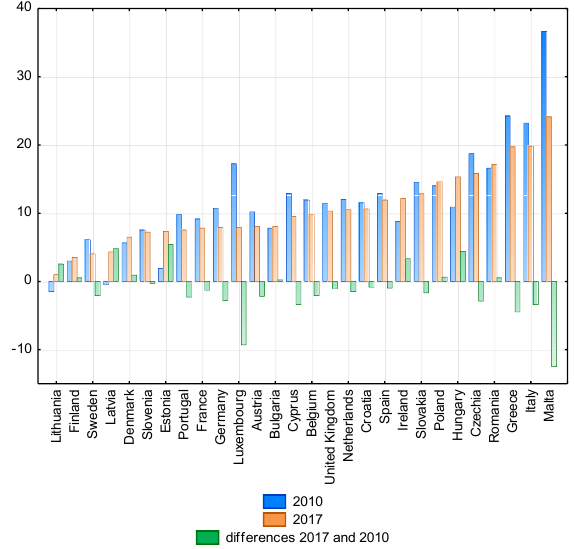
Figure 6. Employment rate gender gap in the European Union countries for the years 2010 and 2017 Table 2. Wilcoxon matched pairs test for the years 2010 and 2017